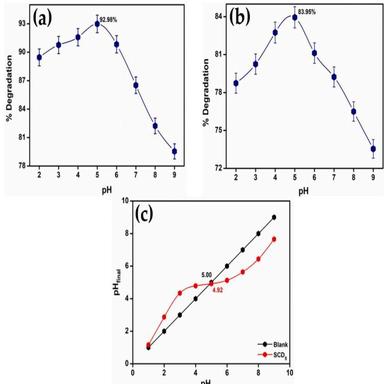
Time-independent (at 80 min) variation of pH of (a) Rh–B and (b) MB dye solution against %degradation. (c) pHinitial v/s pHfinal for evaluating PZC.